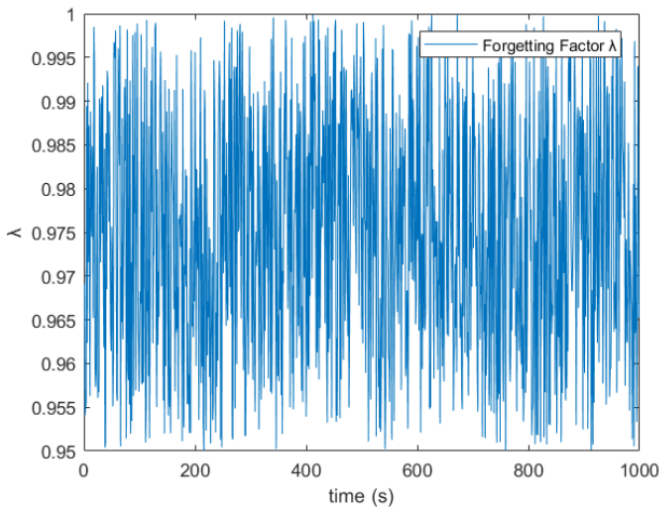
Figure 3. Adaptive forgetting